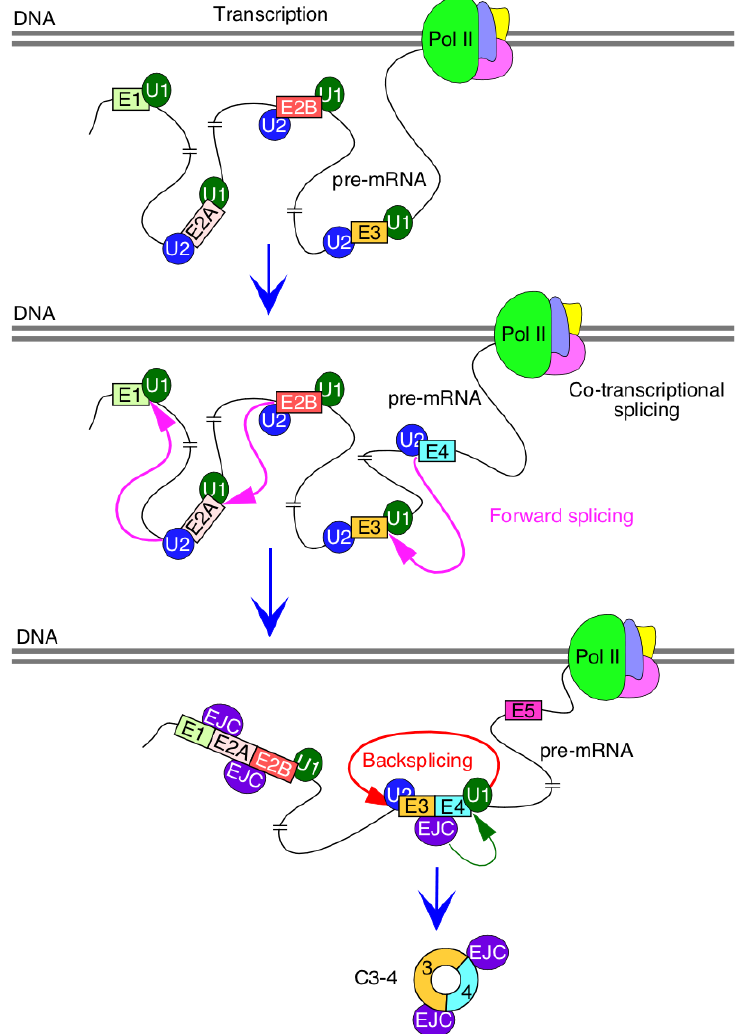
Figure 7. Mechanism of SMN circRNA generation. Splicing factors and U snRNP are recruited during transcription by RNA polymerase II (pol II). Many introns could be potentially removed by forward splicing while pol II is still transcribing. Removal of introns is accompanied by deposition of exon junction complex (EJC) at the exon-exon junction. In some instances, EJC may help recruit splicing factors and promote splicing of neighboring introns. We hypothesize that EJC deposited at the junction of exons 3 and 4 promotes backsplicing involving the 5 ′ ss of exon 4.